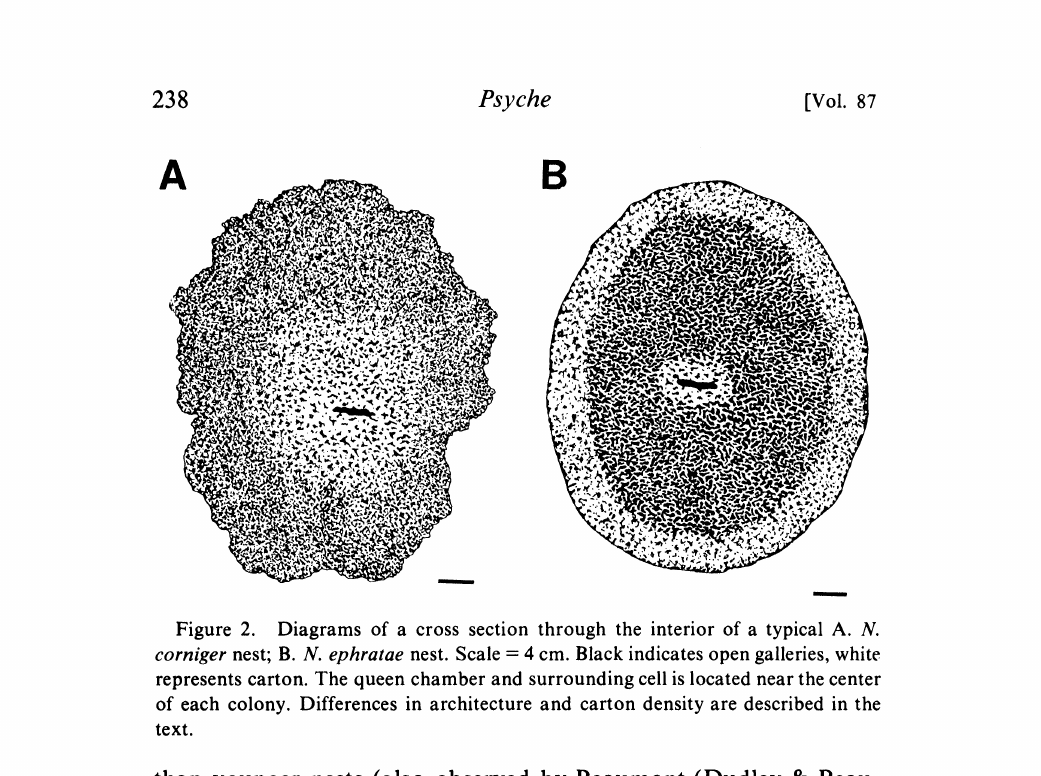
Figure 2. Diagrams of a cross section through the interior of a typical A. N. corniger nest; B. N. ephratae nest. Scale 4 cm. Black indicates open galleries, white represents carton. The queen chamber and surrounding cell is located near the center of each colony. Differences in architecture and carton density are described in the